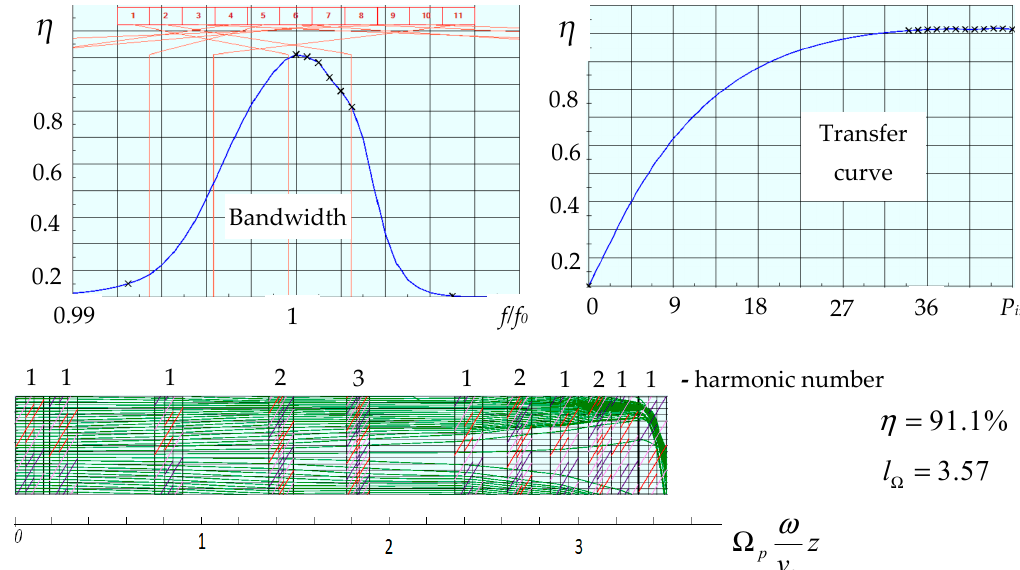
Figure 9. Result of syntheses of CSM klystron by embedding procedure.